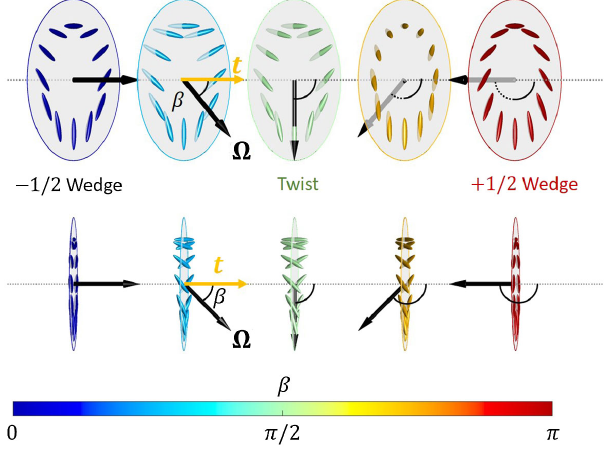
FIG. 2. A local − 1 = 2 wedge can continuously transform into a þ 1 = 2 wedge via an intermediate twist disclination [12]. The director field winds about the rotation vector Ω (black arrows) by an angle π . The angle between the rotation vector Ω and the local disclination line tangent t (yellow arrow), called the twist angle β , varies continuously along a disclination line. Twist disclinations correspond to β ¼ π = 2 and þ 1 = 2 and − 1 = 2 wedge disclinations to β ¼ π and 0, respectively.